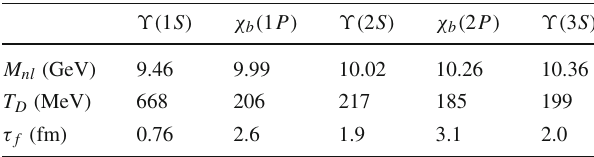
Table 3 The values of mass ( M nl ), dissociation temperature ( T D ) and formation time ( τ f ) are taken from Refs.